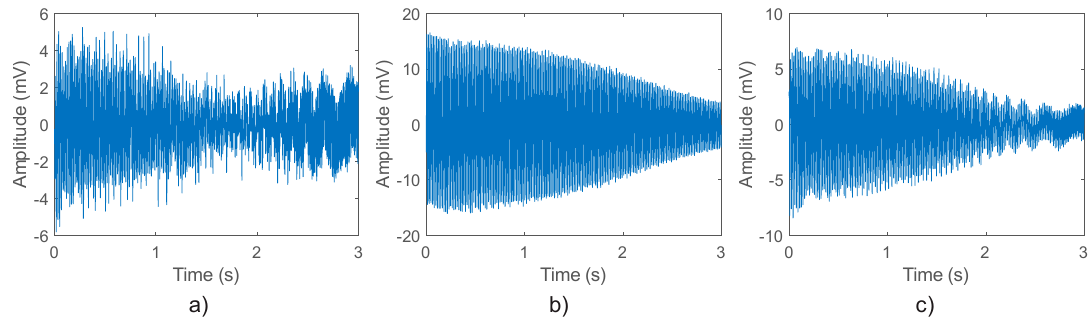
Figure 7. Time–domain signals captured by the proposed triaxial stray flux sensor: ( a ) axial stray flux; ( b ) combination of the axial and radial stray flux; ( c ) radial stray flux.